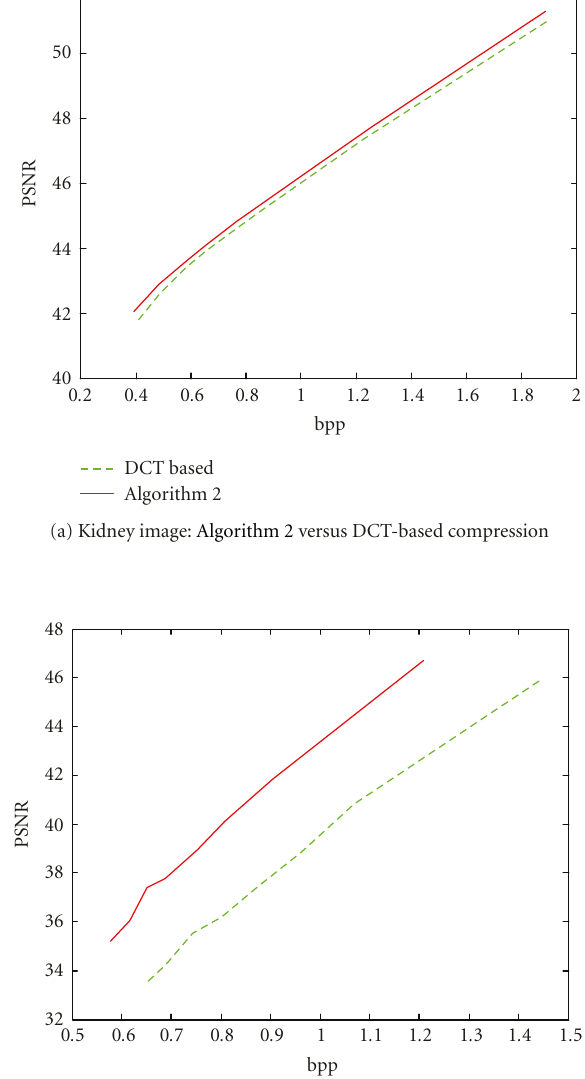
erty, especially for images composed of subimages of